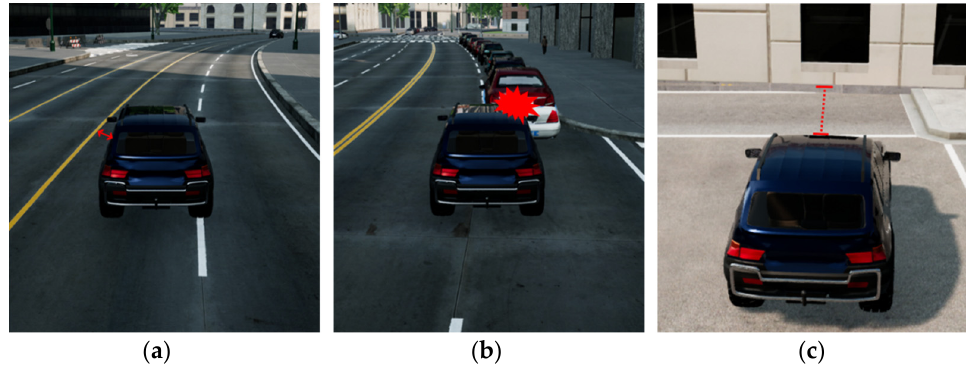
Figure 7. Three stop conditions of simulation episodes. ( a ) Too close to the lane. ( b ) Collision occurred ( c ) Stop the car.